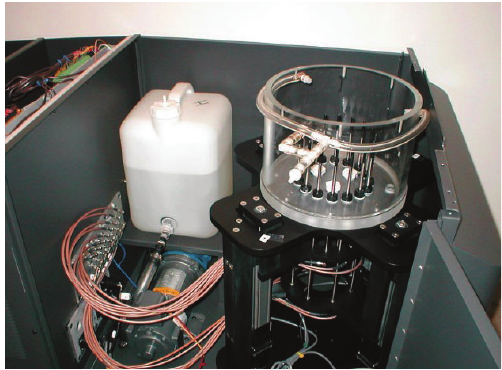
Figure 2: Photo of the measurement system. During patient examinations, the patient is to lie prone on top of the system with her breast suspended through an aperture in the top of the system. Data is collected for seven di ff erent planes along the length of the breast. This is done by moving the circular antenna array vertically along the suspended